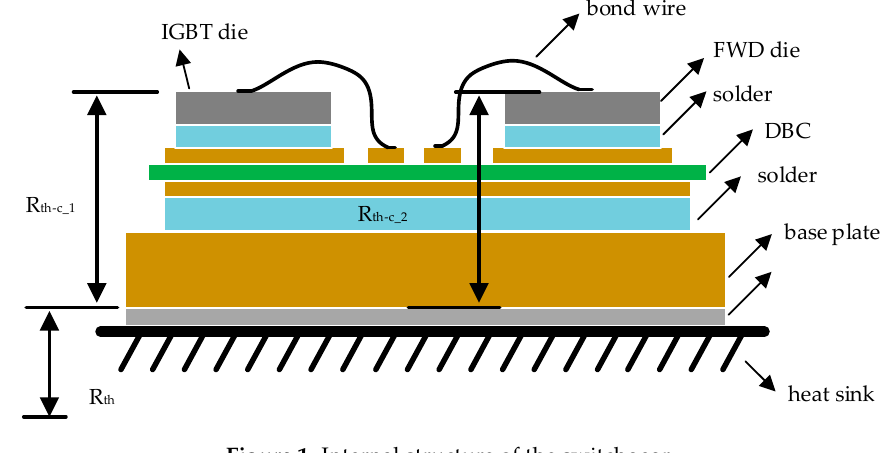
Figure 1. Internal structure of the switchgear.